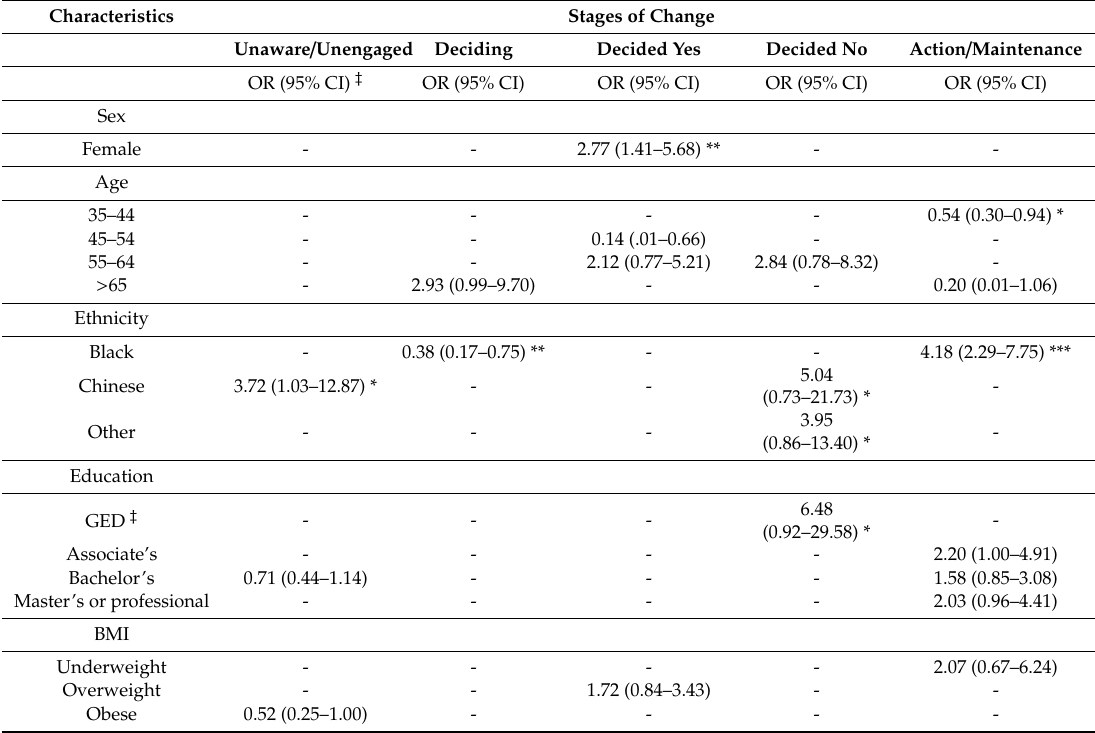
Table 8. Backward stepwise logistic regression of stage of change by demographic factors in the OtherUS